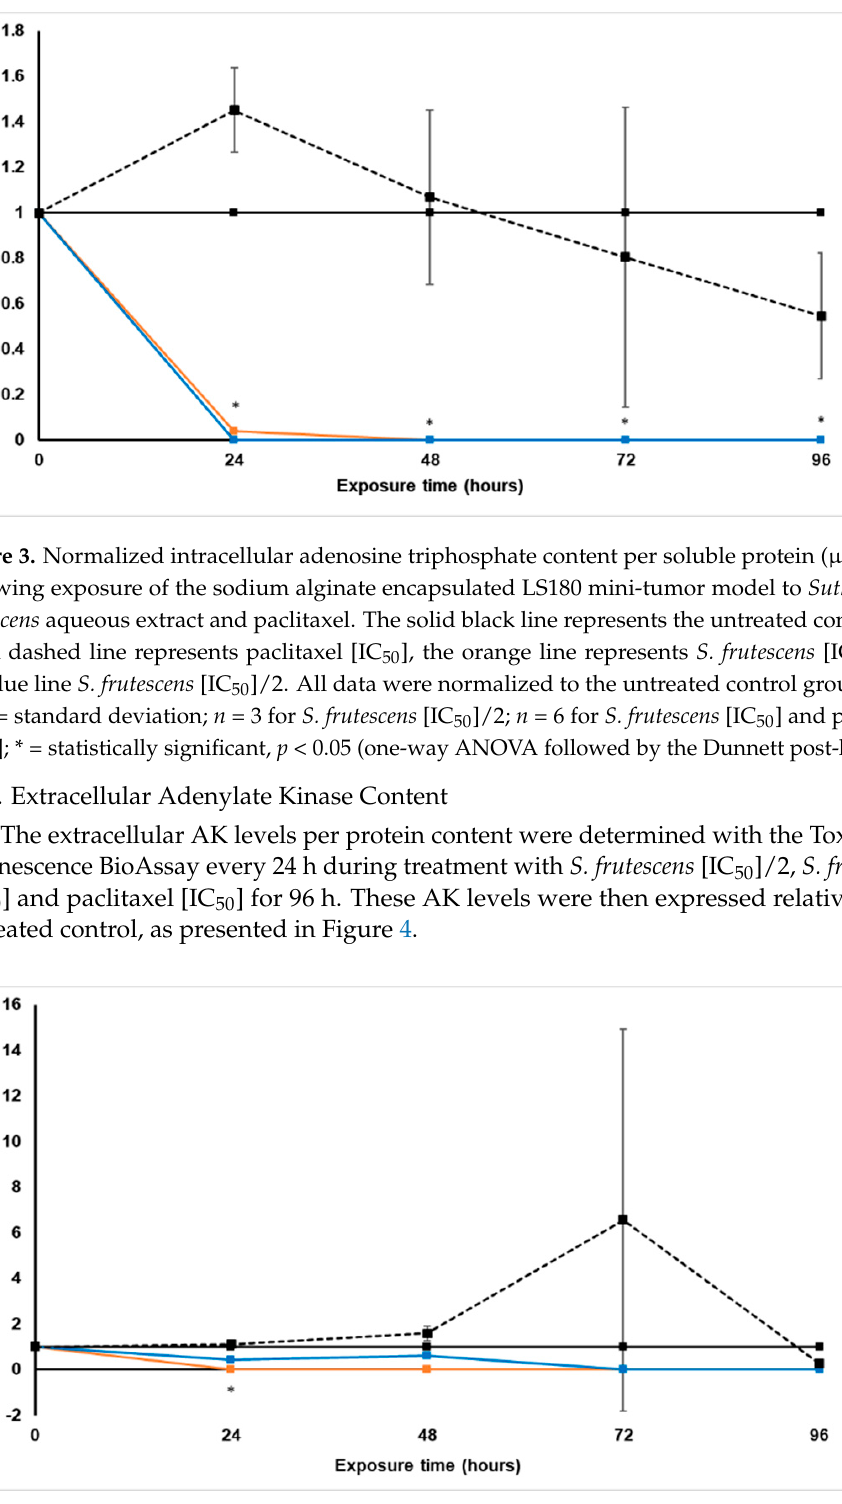
Figure 4. Normalized extracellular adenylate kinase release per microgram protein following ex- posure of the sodium alginate encapsulated LS180 mini-tumor model to Sutherlandia frutescens aqueous extract and paclitaxel. The solid black line represents the untreated control, the black dashed line represents paclitaxel [IC 50 ], the orange line represents S. frutescens [IC 50 ] and the blue line S. frutescens [IC 50 ]/2. All data were normalized to the untreated control group (error bars = standard deviation; p < 3 for S. frutescens [IC 50 ]/2; n = 6 for S. frutescens [IC 50 ] and paclitaxel [IC 50 ]; * = statistically significant, p < 0.05 (one-way ANOVA followed by the Dunnett post-hoc test).